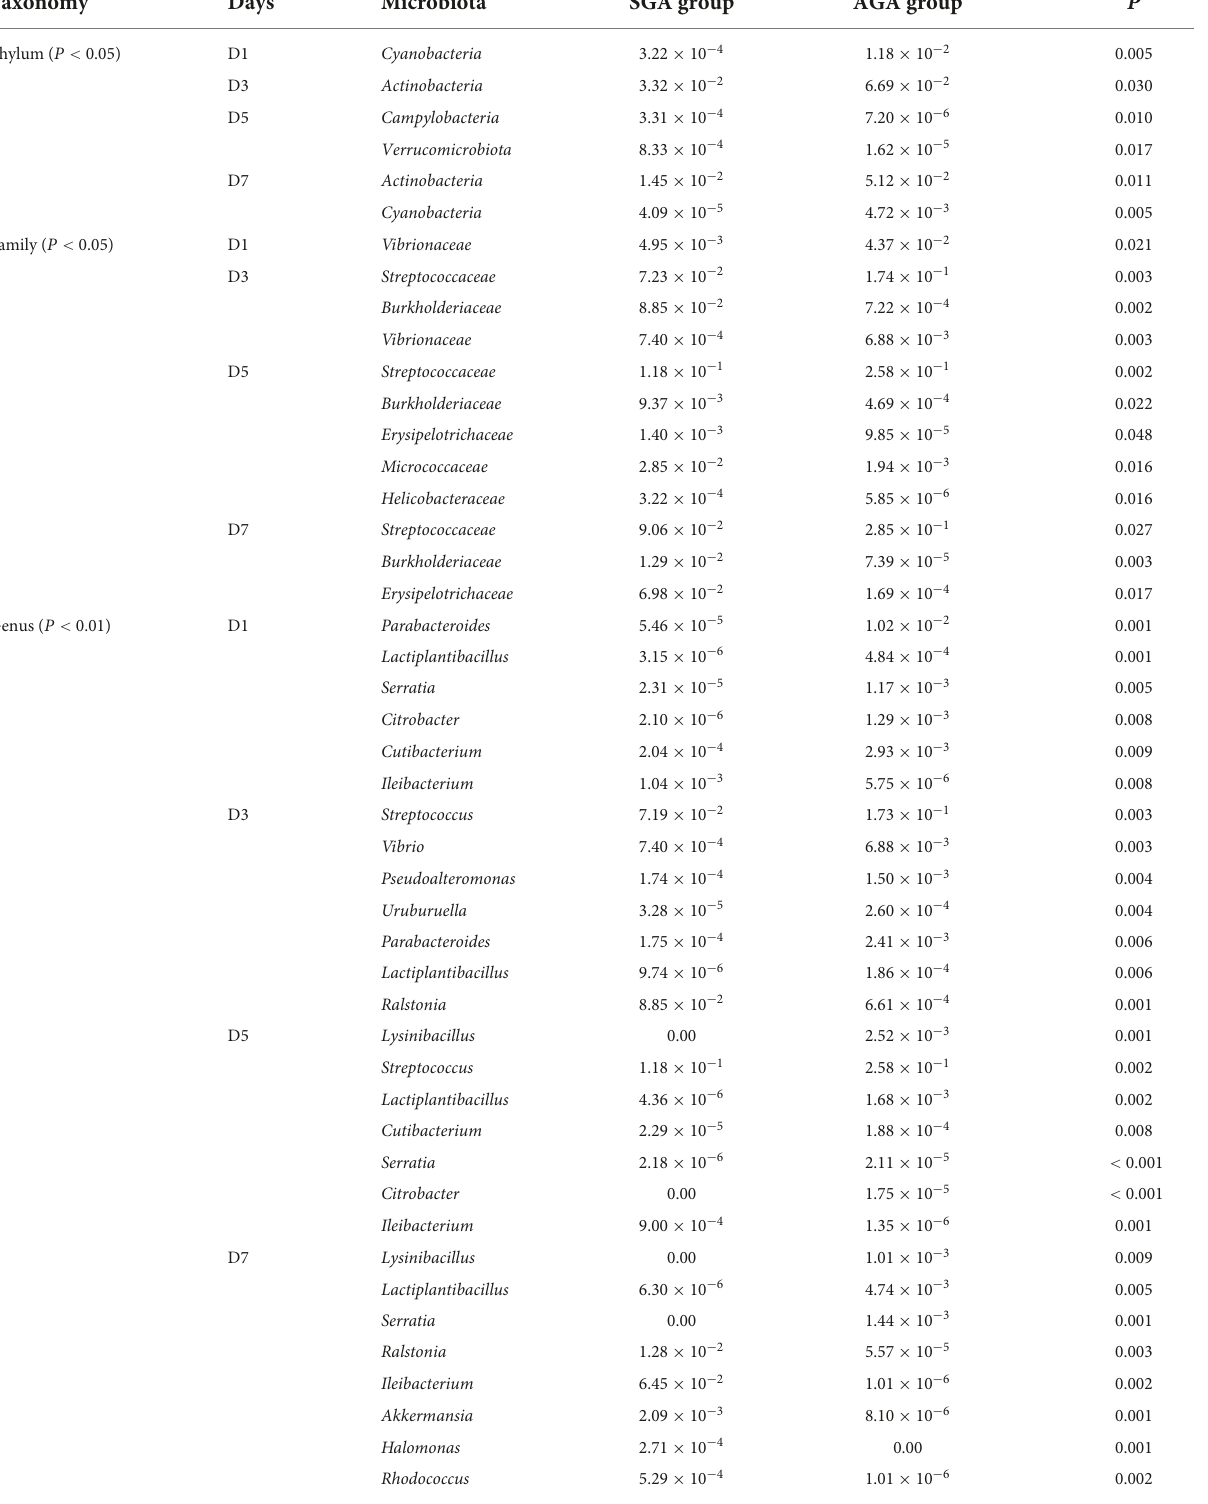
TABLE 2 Gut microbiota analysis of the SGA and AGA groups on days 1, 3, 5, and 7 at levels of phylum, family, and genus.